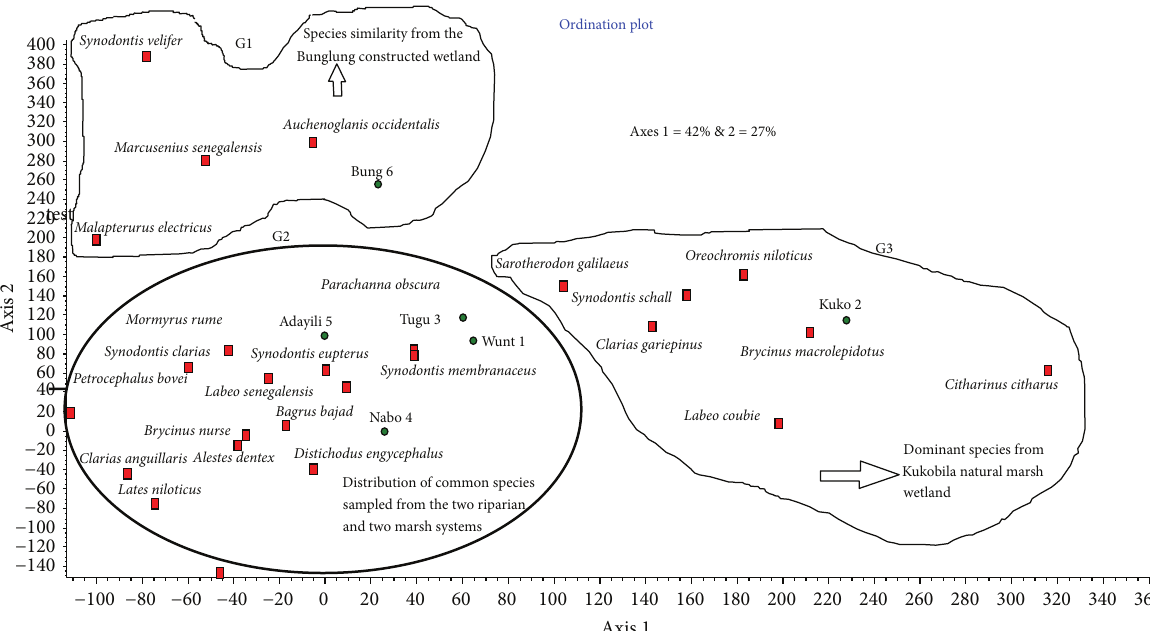
Figure 5: Detrended correspondence analysis (DCA) ordinations, showing fish community structure and distribution, into three groups. The red squares denote fish species, while the green circles denote sample sites. Environmental influences accounted for 69% of variations in fish community structure and distribution, while the remaining 31% was explained by a matrix of unidentified environmental and natural factors.